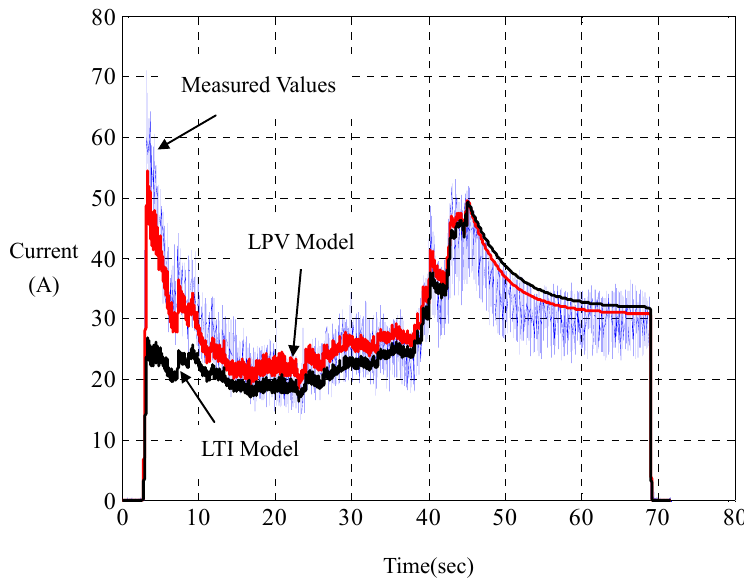
Figure 5. Current comparison of linear parameter-varying (LPV) with linear time-invariant (LTI) parameterizations.